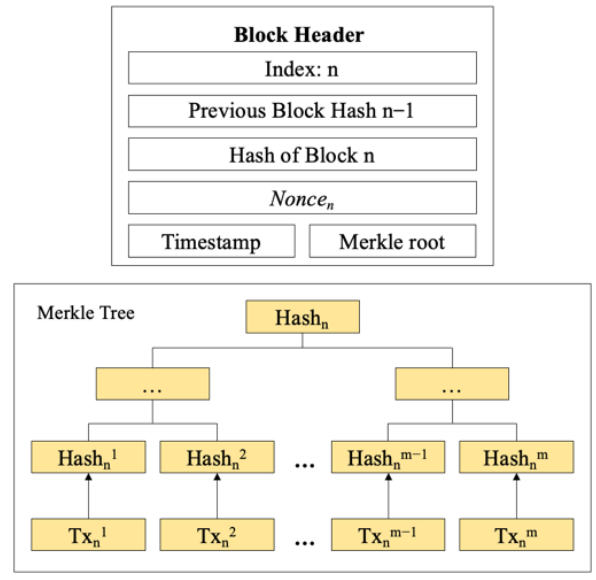
Figure 2. Basic structure of block.